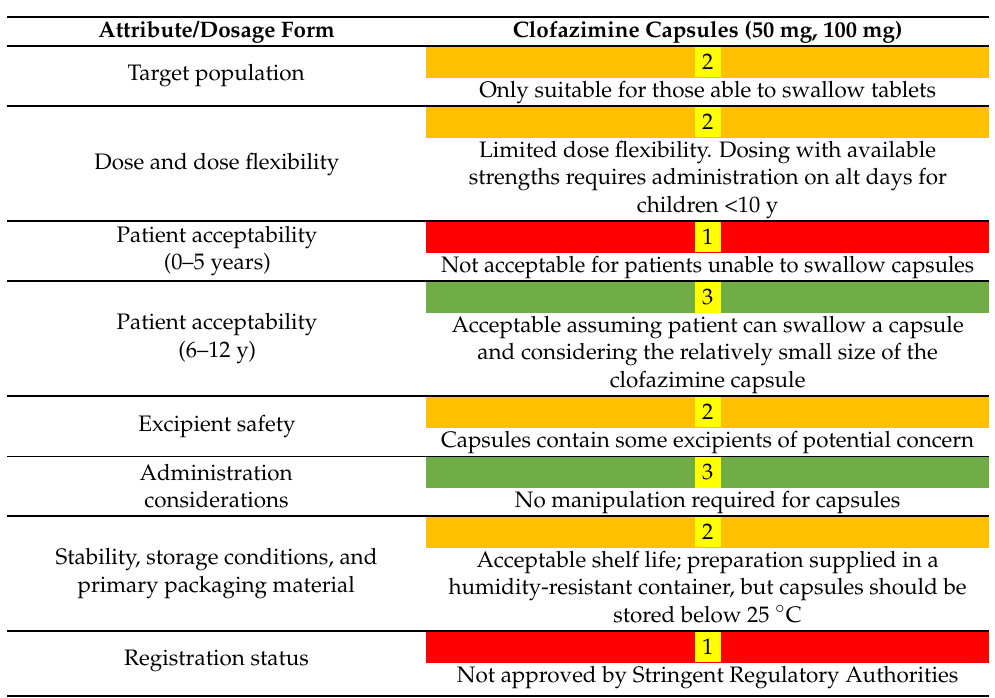
Table 4. pQTPP summary for clofazimine formulations listed in the WHO Essential Medicines List for children in the Antileprosy medicines section (Section